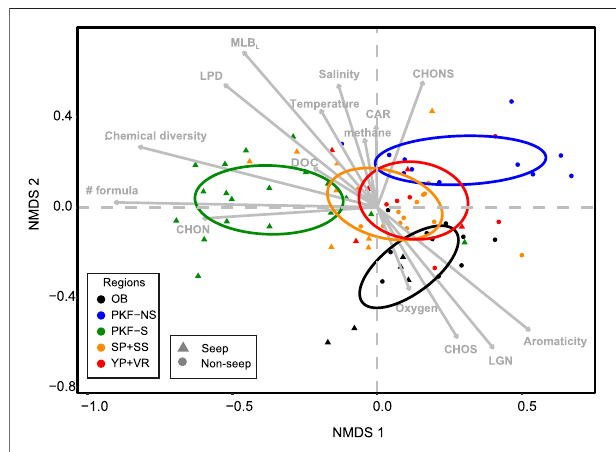
FIGURE 8 | Non-metric multidimensional scaling (NMDS) biplot of Jaccard distances from the presence/absence matrix of dissolved organic matter molecular formula compositions containing C c H h N n O o S s by ESI FT- ICR MS. Samples are coded by colour and shape for site and seepage in fl uence, respectively. Arrow vectors represent environmental variables (oxygen, DOC, temperature, salinity, and methane concentration), numerical observations (number of formulas, chemical diversity, aromaticity (Hockaday et al., 2009)) and molecular percentages (CHOS, CHON, CHONS, LPD, LGN, CAR, MLB L ,) that show signi fi cant correlation ( p < 0.05) with the NMDS scores. Coloured ellipses represent 95% con fi dence interval of the group centroids. Abbreviations are LPD, lipid- and protein-like; CAR, carbohydrate- like; LGN, lignin-&tannin-like; UHC, unsaturated hydrocarbon- &condensed aromatic-like; DOC, dissolved organic carbon; MLB L , percentages of formulas above the molecular lability boundary (D ’ Andrilli et al. 2015).